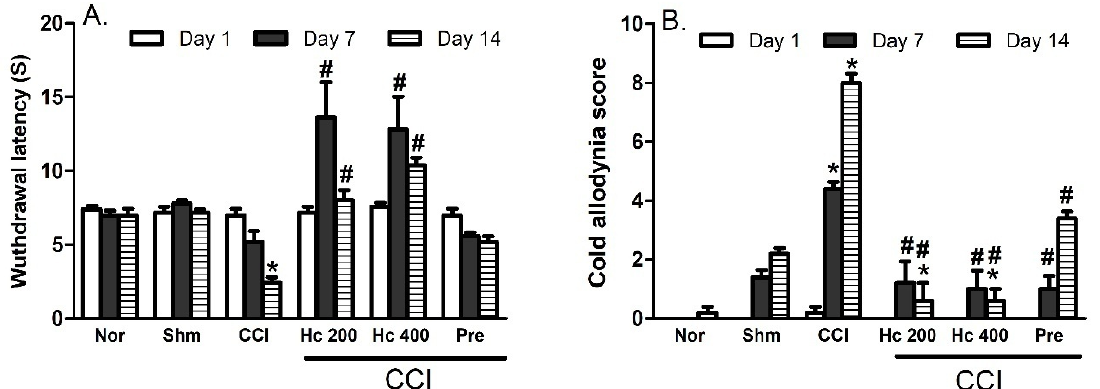
Figure 6. Effects of H. campechianum flower extract (200 and 400 mg/kg) on ( A ) heat hyperalgesia (withdrawal latency) and ( B ) cold allodynia responses in rats with neuropathic pain induced by ligation of spinal nerve. Data are presented as mean values ± S.E.M (n = 5). * p < 0.05, compared to sham group; # p < 0.05, compared to CCI group at the corresponding time points. CCI, chronic constriction injury; Hc, H. campechianum ; Nor, normal; Pre, pregabalin; Shm,